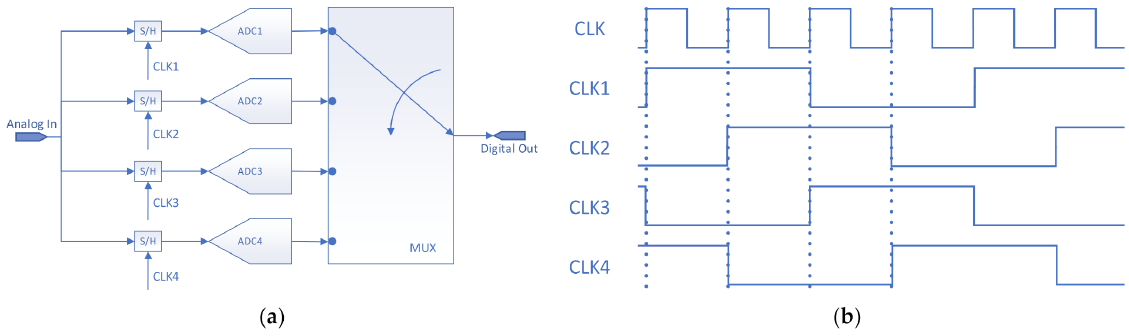
Figure 1. ( a ) TIADC system diagram; ( b ) time sequence diagram of each ADC in a TIADC